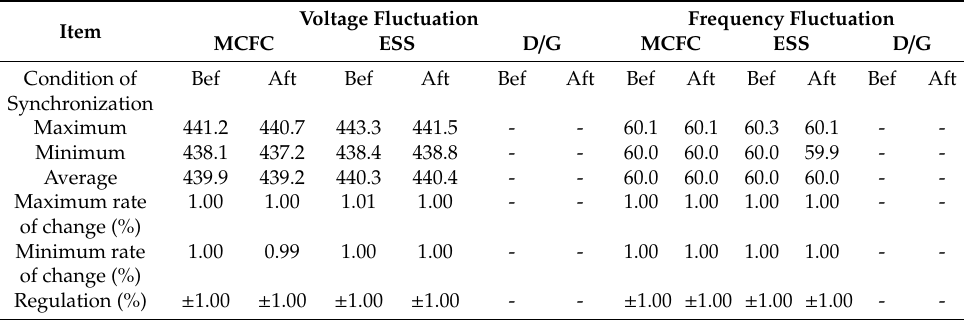
Table 14. Power data analysis before and after ESS system